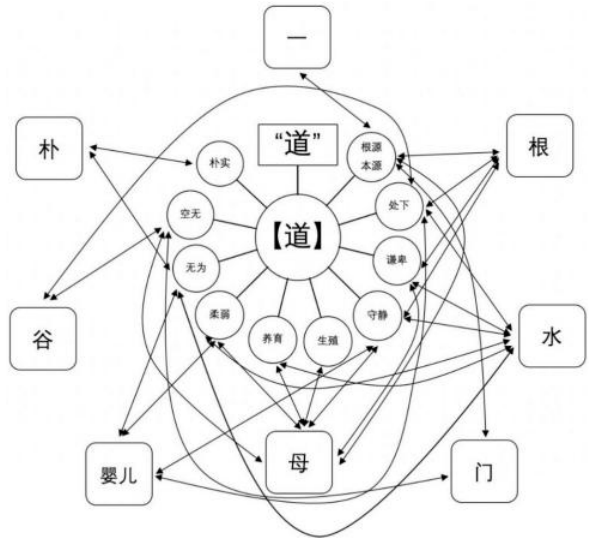
Figure 1. The conceptual metaphor field of Dào in the Dào Dé J ī ng. Table 1. Terms in Figure 1.